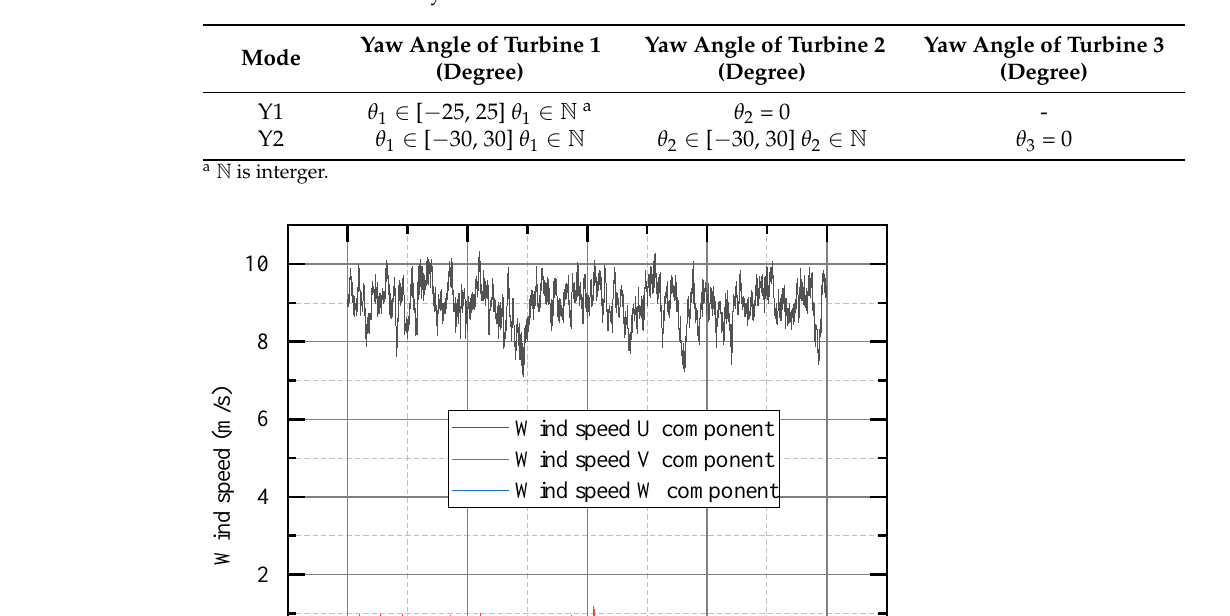
Table 2. Parameters of yaw control.